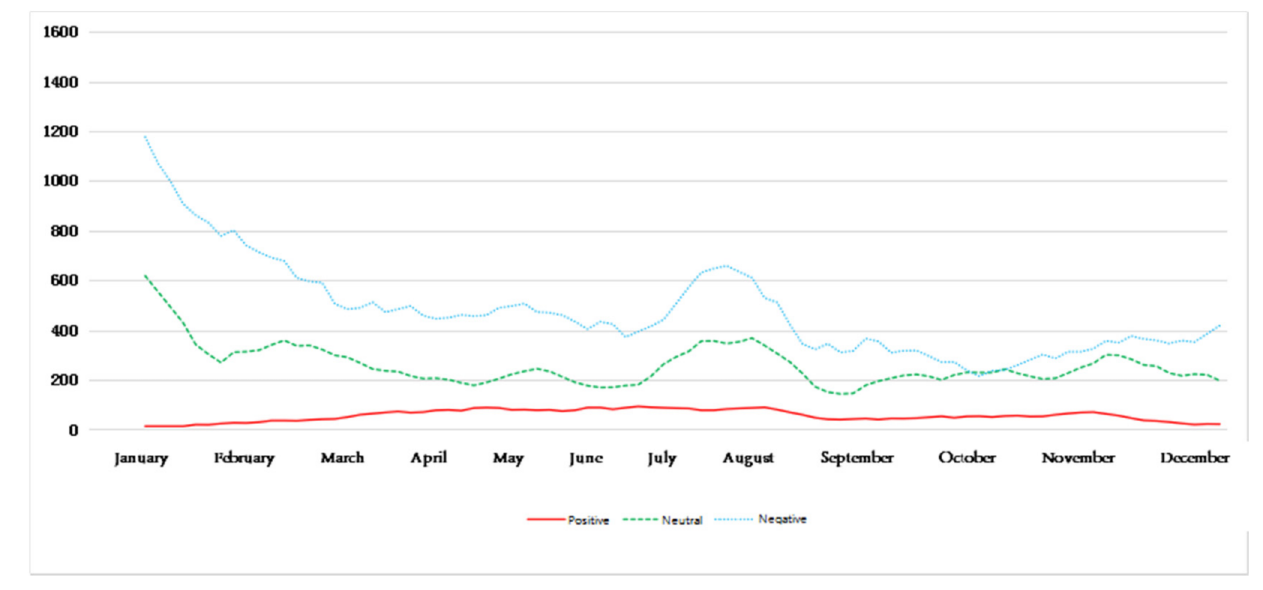
Figure 9. Five-day moving average of perceived emotions in autumn.